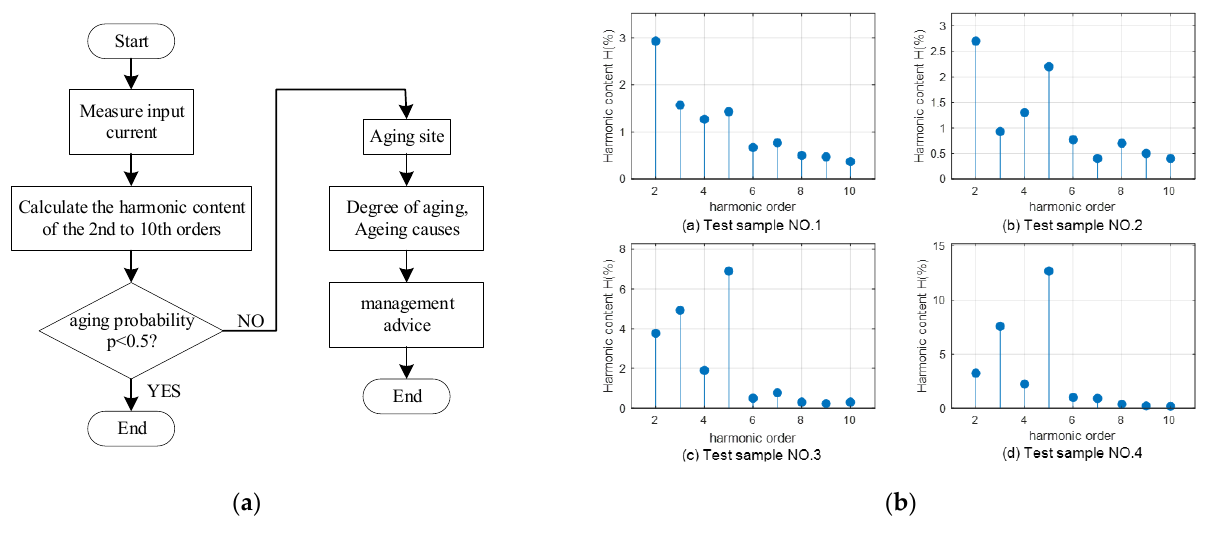
Figure 7. Survey photos: ( a ) The flowchart of cables aging detection; ( b ) Four of the test samples. Table 3. The theoretical fault value and output value of the network. The Sample